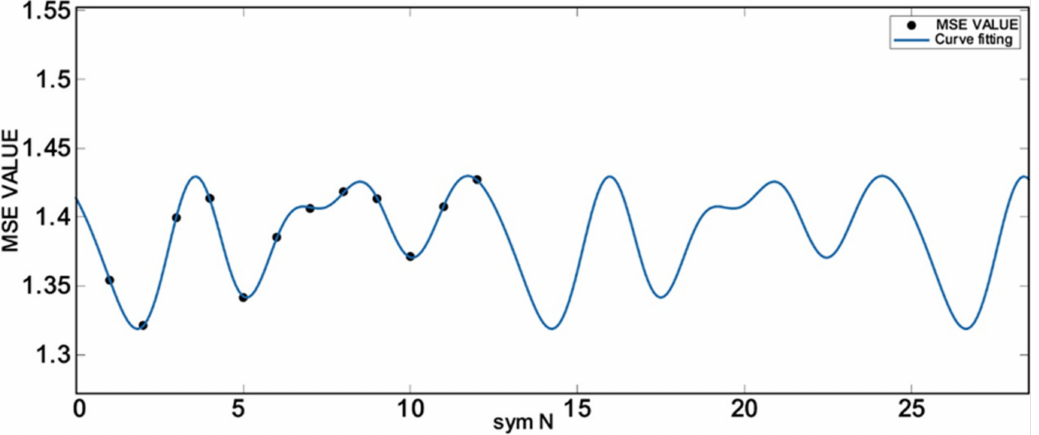
Figure 9. The sym wavelet packet base MSE fitting curve.